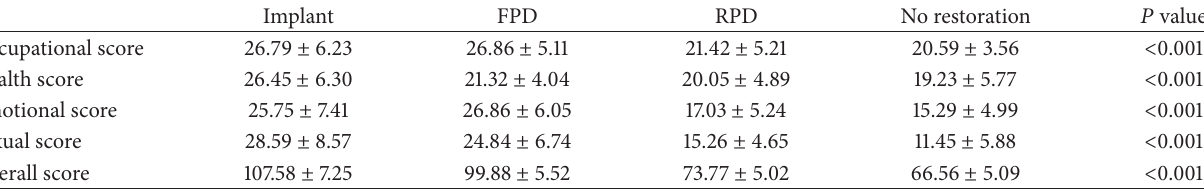
Table 2: Utian QoL survey